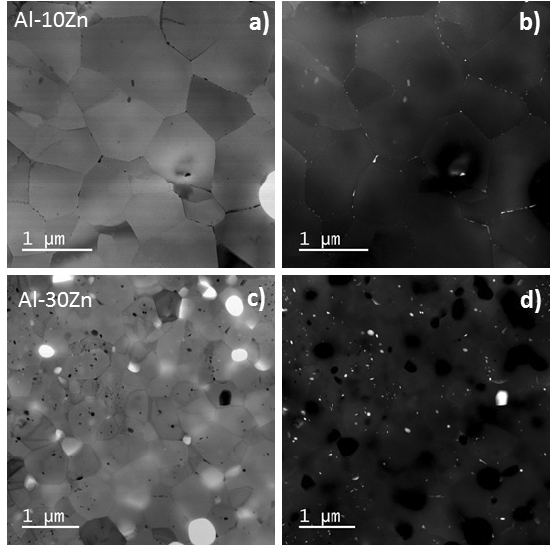
Fig. 4. (a, c) - STEM-BF and (b, d) - STEM-HAADF images showing the microstructure of the: (a, b) - Al-10Zn after SPD followed by static annealing at 200 ° C during 10 min and (c, d) - Al-30Zn after SPD followed by static annealing at 250 ° C during 10